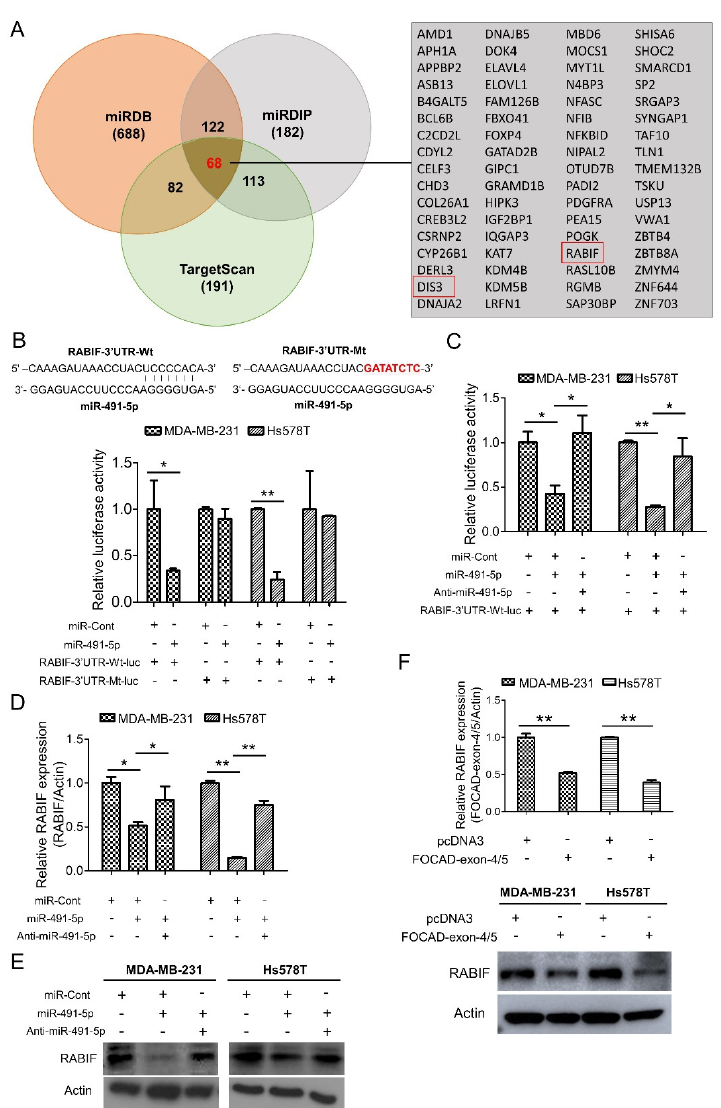
Figure 4. Identification of RABIF as the direct target of miR-491-5p. ( A ) Left, the number of potential targets of miR-491-5p determined by three bioinformatics algorithms (miRDB, miRDIP, and TargetScanHuman 7.2) is shown by Venn diagram. Right, the detailed list of 68 potential targets of miR-491-5p. ( B ) Effect of miR-491-5p on luciferase activity of RABIF-3 (cid:48) UTR-Wt-luc (wild type) and RABIF-3 (cid:48) UTR-Mt-luc (mutant) in MDA-MB-231 and Hs578T cells.Top, the RABIF-3 (cid:48) UTR-Wt-luc sequence and the RABIF-3 (cid:48) UTR-Mt-luc sequence in which the sequence in red was mutagenized to abolish the binding between miR-491-5p and RABIF-3 (cid:48) UTR. Bottom, luciferase reporter assay showed decreased activity of more than 50% after cotransfection with miR-491-5p and RABIF-3 (cid:48) UTR-Wt-luc in MDA-MB-231 and Hs578T cells. The activity of RABIF-3 (cid:48) UTR-Mt-luc was not significantly affected by miR-491-5p. ( C ) The expressions of luciferase activity of RABIF-3 (cid:48) UTR-Wt-luc (wild type) in MDA- MB-231 and Hs578T cells upon transfection with the indicated plasmids. ( D ) The mRNA expression levels of RABIF were measured by qRT–PCR from MDA-MB-231 and Hs578T cells transfected with the indicated plasmids. ( E ) The protein expression levels of RABIF as reflected by Western blotting analysis in MDA-MB-231 and Hs578T cells transfected with the indicated plasmids are shown. Actin was served as an internal control. ( F ) The mRNA (top) and the protein (bottom) expression levels of RABIF were measured by qRT–PCR and Western blotting analysis from MDA-MB-231 and Hs578T cells transfected with the indicated plasmids. All histograms represent means ± s.e. from three independent experiments (* p < 0.05, ** p < 0.01). All experiments were performed in triplicates and were done at least three